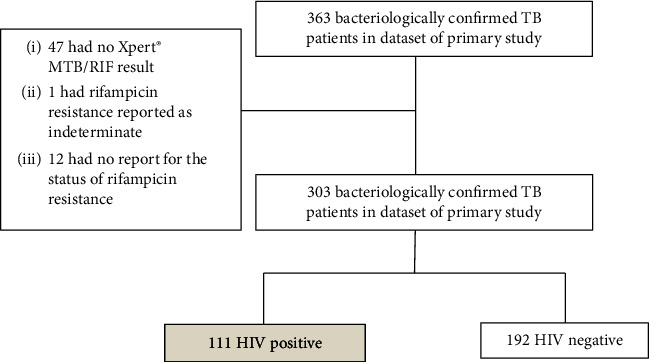
Study flow diagram.